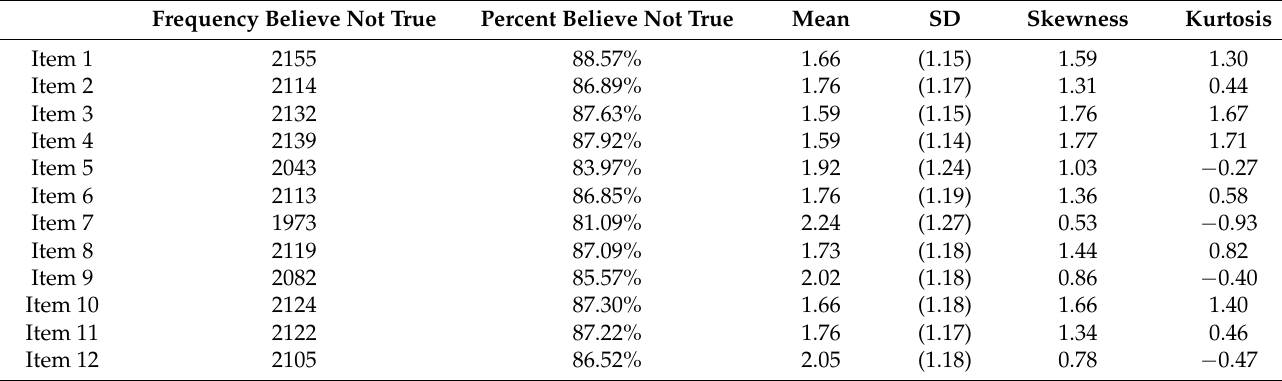
Table 3. Descriptive statistics of items considered COVID-19 transmission misinformation.